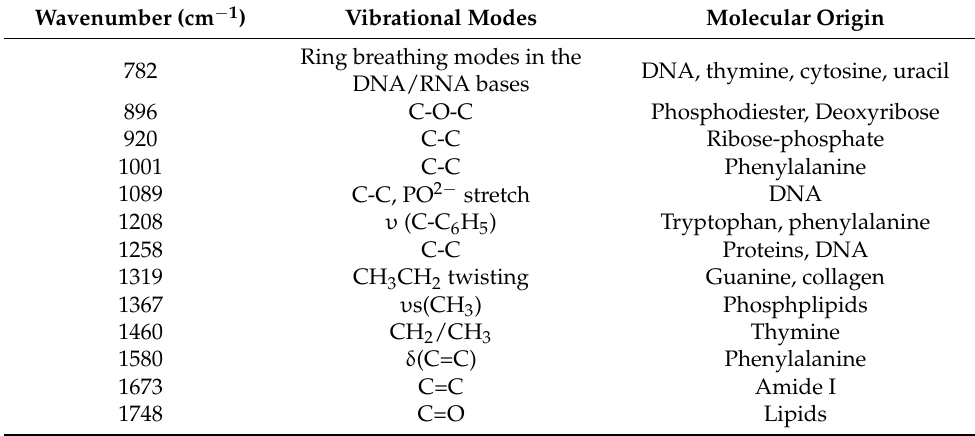
Figure 2. ( a ) Bright-field image of sperm cells on the glass after staining, scale bar =5 μ m; ( b ) Raman spectra acquired from sperm cell heads, in which the blue line represents Raman spectra from DNA- intact sperm cell, while the red line indicates the spectra from DNA-damaged sperm cell. The black line represents their difference spectrum. Table 1. Vibrational modes and molecular assignment of the Raman peaks.